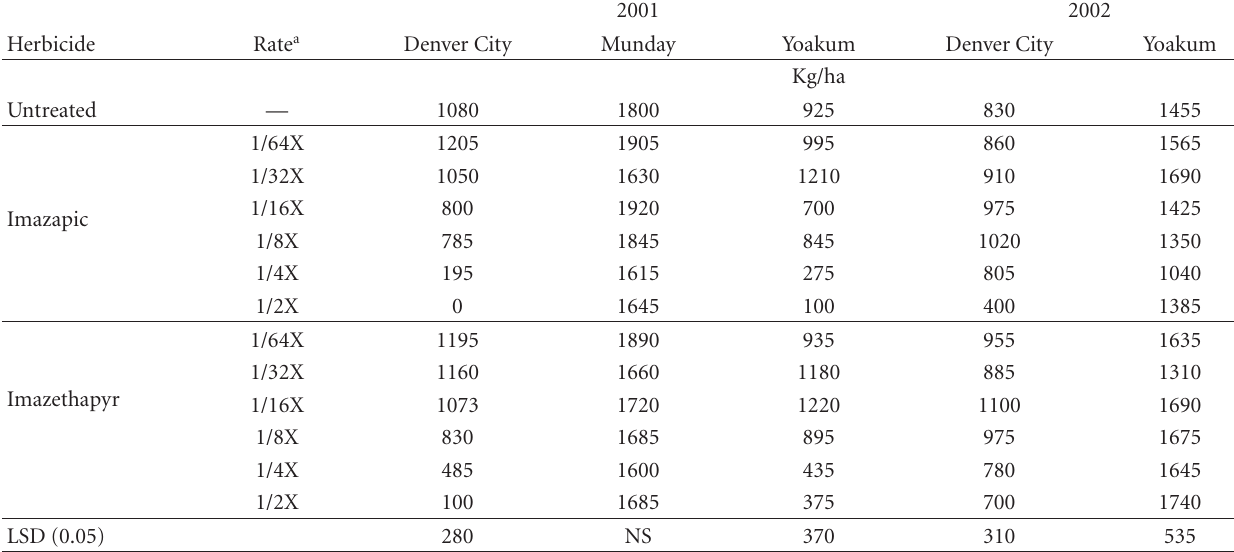
Table 3: Cotton lint yield as a ff ected by simulated rates of imazapic and